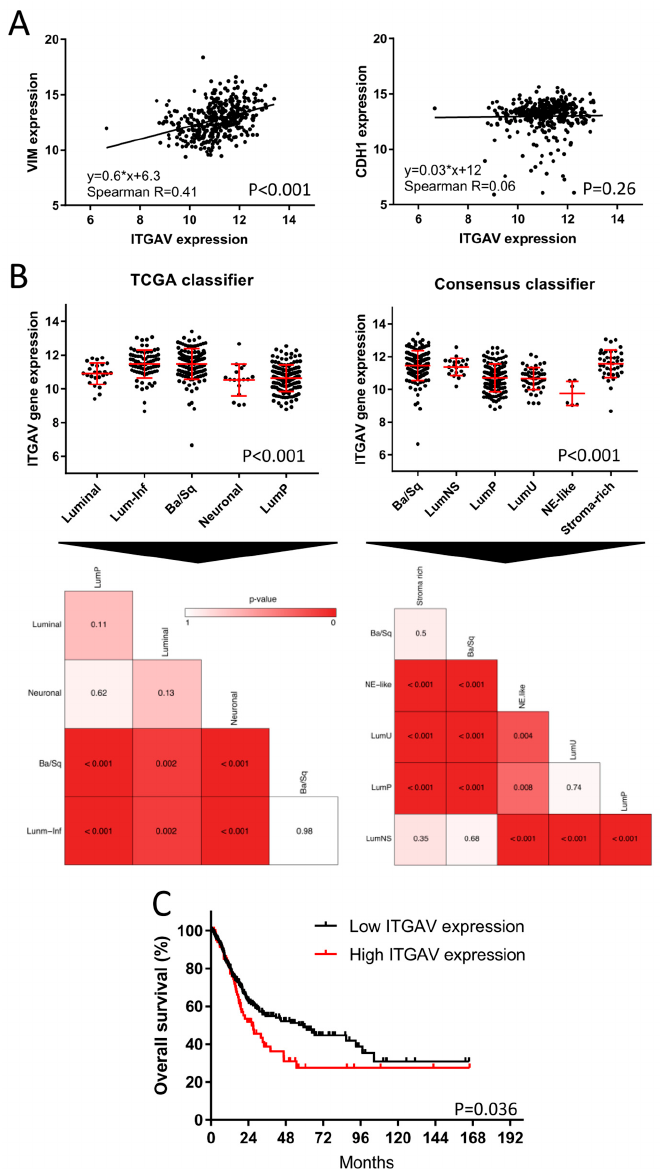
Figure 5. Evaluation of ITGAV expression in bladder cancer patients of the TCGA cohort. ( A ) BLCA TCGA Cohort ( n = 386): Spearman correlation between ITGAV and vimentin ( VIM ) or CDH1 gene expression as representative biomarkers for EMT. ( B ) Subtype-specific expression of ITGAV based on the TCGA and Consensus subtype taxonomies ( n = 386). Heatmaps were used for the comparison of the statistical significance based on the differential gene expression of ITGAV between all subtypes. ( C ) Kaplan–Meier plot with log-rank comparison between overall survival of patients with high ( n = 84) versus low ITGAV expression ( n = 302).